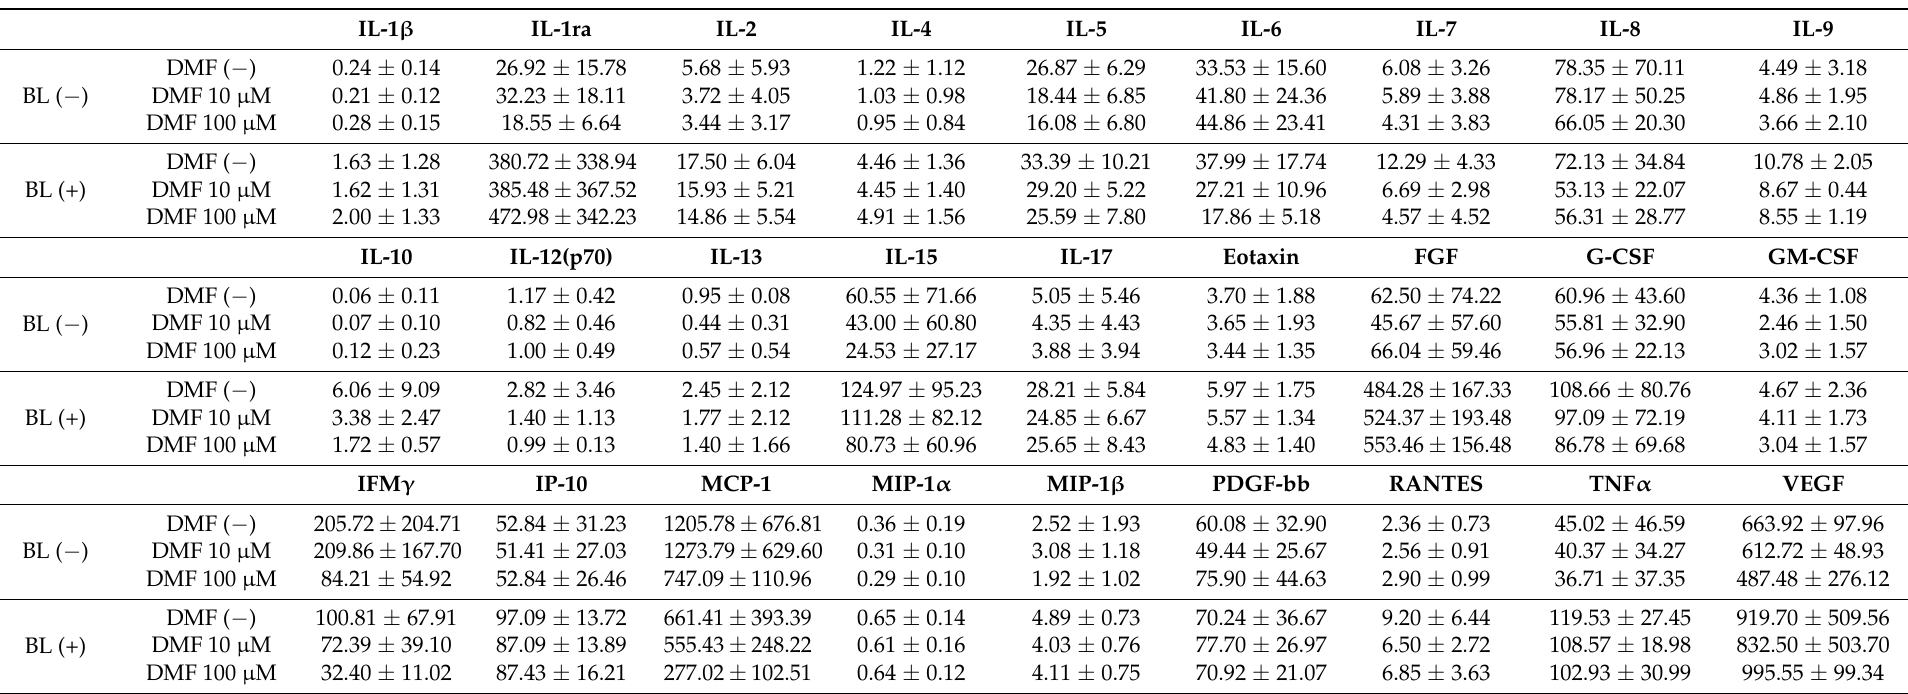
Table 1. Cytokine levels (pg/mL) in the supernatant from ARPE-19 cells treated with DMF under blue light